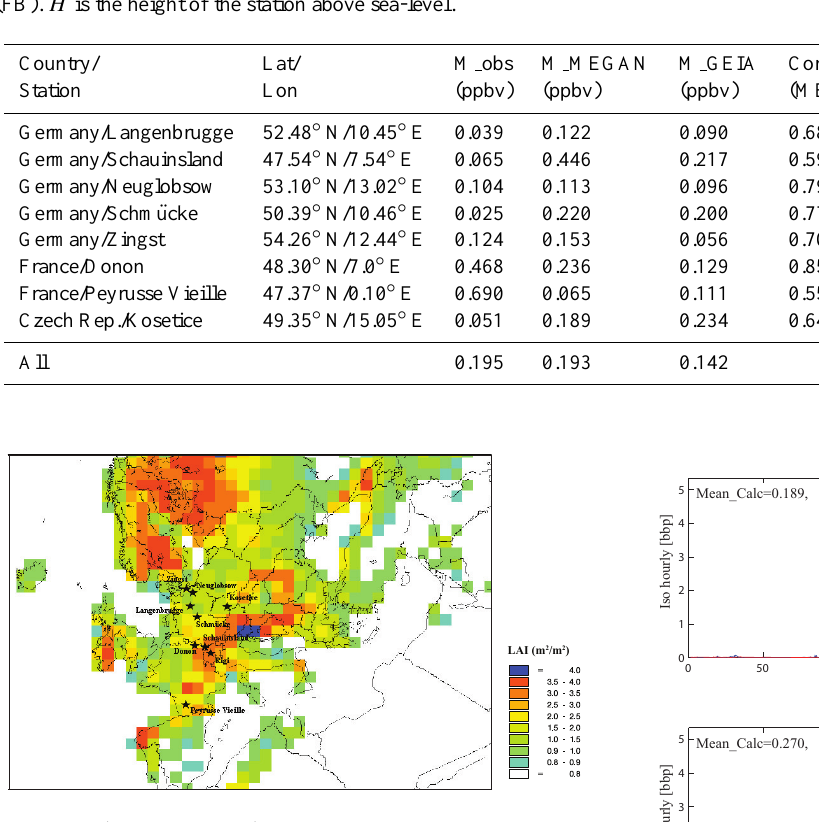
Fig. 9. LAI (Leaf Area Index) emission activity factor from PCEEA MEGAN approach described by Guenther et al. (2006) for the Eu- rope domain. The asterisks show the location of measuring sites from EMEP measuring network studied in Table 1.